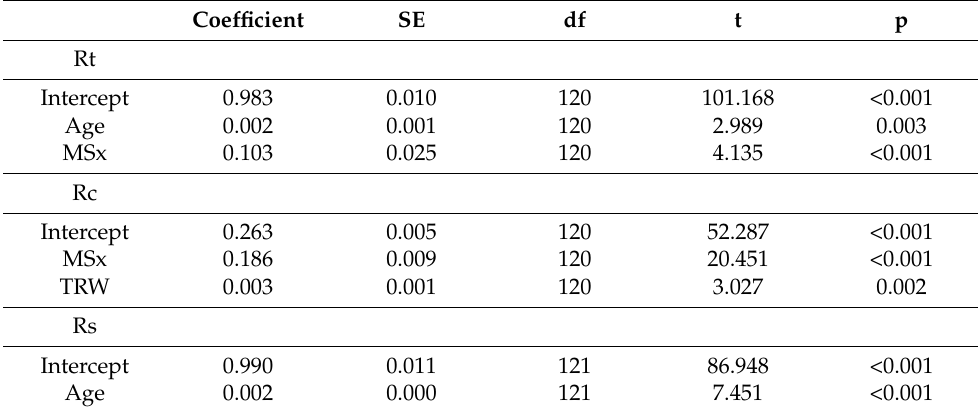
Table 3. Results of the linear mixed-effect models applied on resilience indices (Rt, resistance; Rc, recovery; Rs, resilience). The table shows the coefficients associated to different fixed factors with their standard errors (SE), t statistics of each factor (Age, tree age; MSx, mean sensitivity; TRW, mean tree-ring width) and significance levels ( p